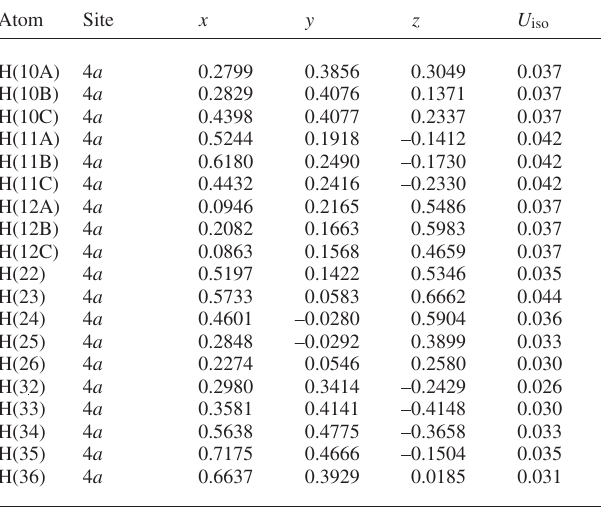
Table 2. Atomic coordinates and displacement parameters (in Å 2 )